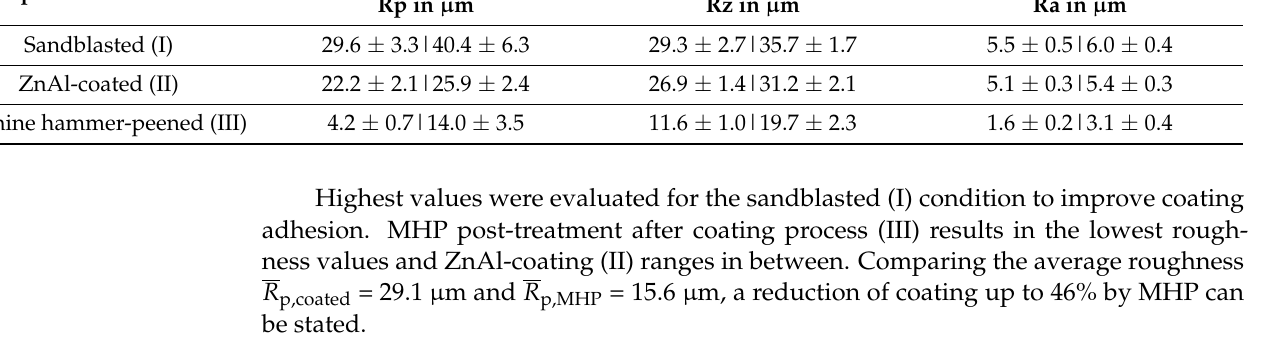
machine hammer-peened (III) specimens.